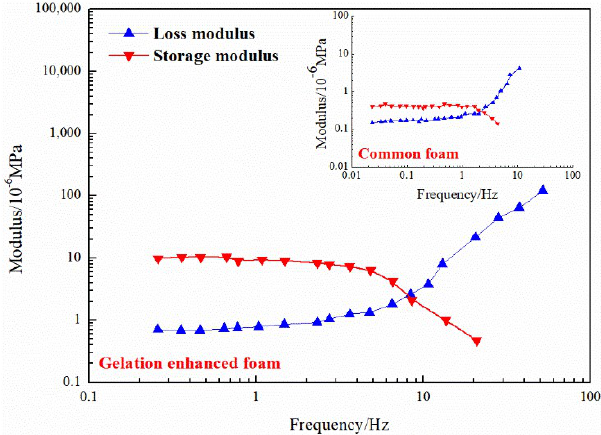
Figure 12. Viscoelasticity comparison: common foam and gel-enhanced foam.